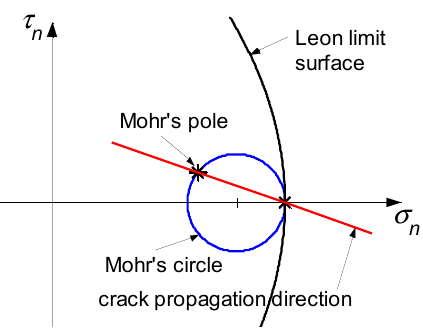
Figure 11. Limit domain of Leon in the Mohr/Coulomb plane.